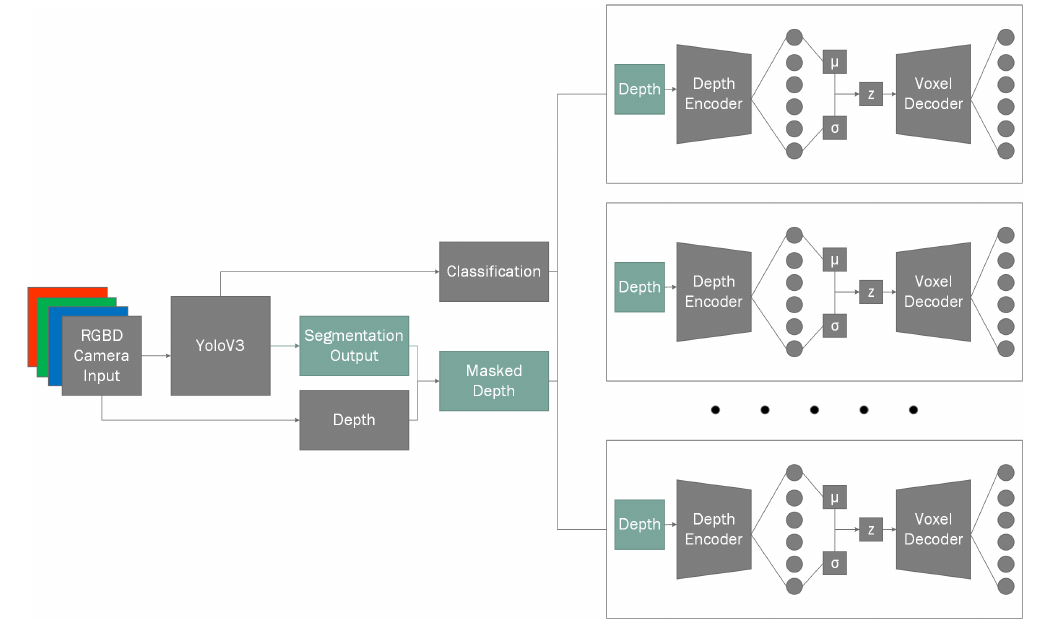
Figure 7. Full view of the proposed network model that extends the YOLOv3